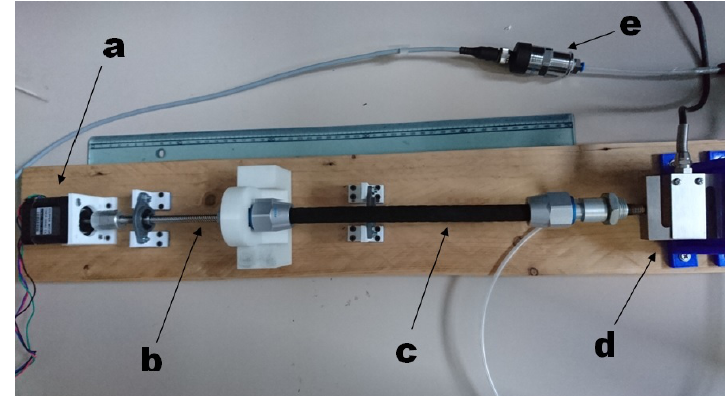
Figure 1. Test rig for the identification of the hysteresis in PAMs. ( a ) stepper motor; ( b ) ball screw; ( c ) artificial muscle; ( d ) load cell; ( e ) pressure sensor.